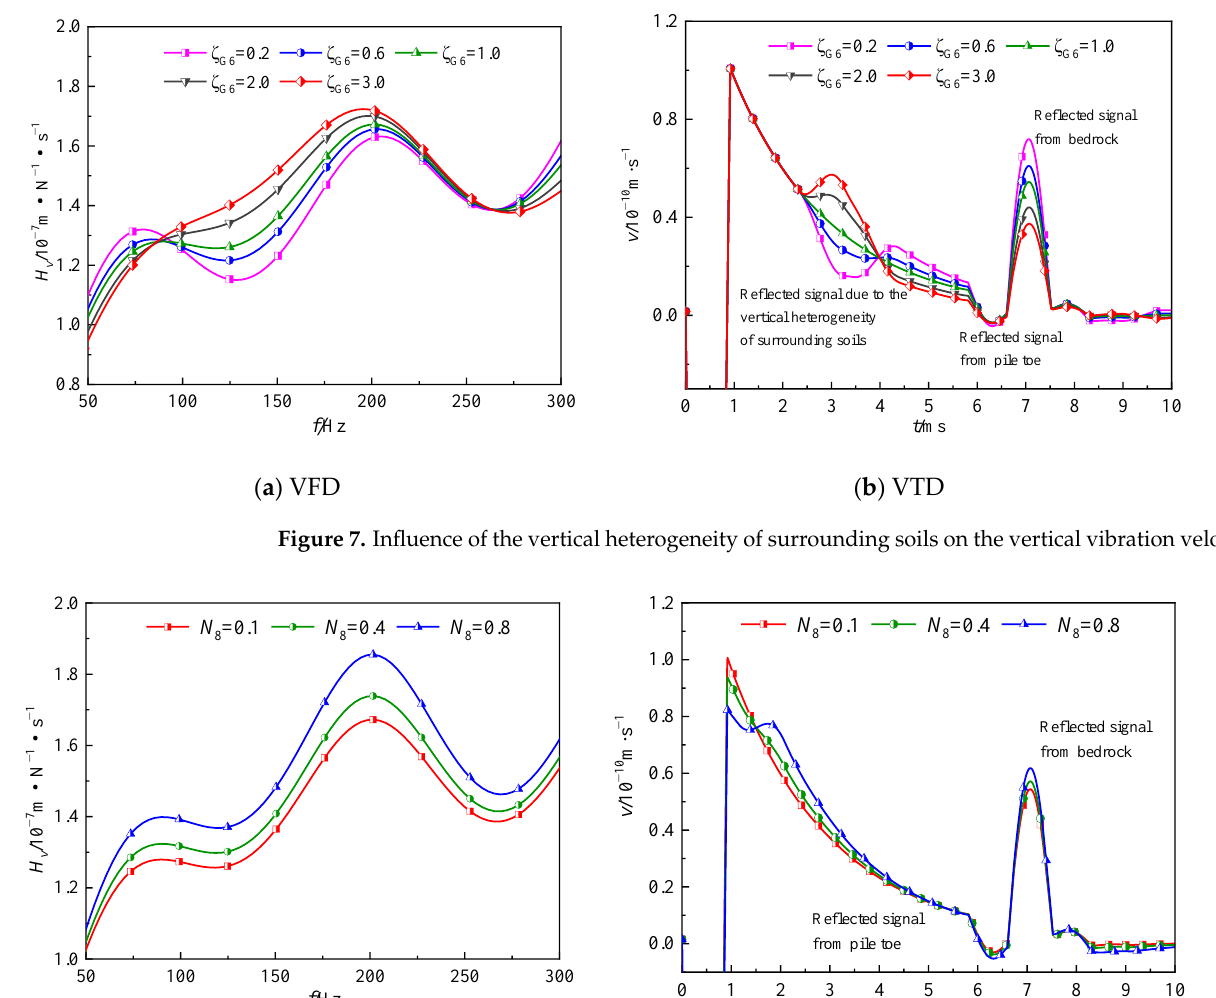
( b ) VTD Figure 9. Effect of the porosity of the pile end soils on pile vertical vibration velocity. 5. Conclusions Based on Biot’s theory, Novak’s plane -strain model and the FSSP model, an analytical methodology for the vibration of a friction pile in multilayered saturated media is pro- posed. The presented approach and relevant solution are validated by comparisons with existing solutions. Furthermore, numerical instances are used to investigate the influences of the porosity and heterogeneity of saturated soils on pile vibration. The results indicate that: (1) With the increase in the length of the FSSP, the resonance amplitude and resonance frequency of the velocity in the frequency domain both have an obvious decrease. Moreover, as the length of the FSSP increases, the RS from the pile remains basically unchanged, but the RS from the bedrock is delayed significantly and its amplitude also has an obvious decline.